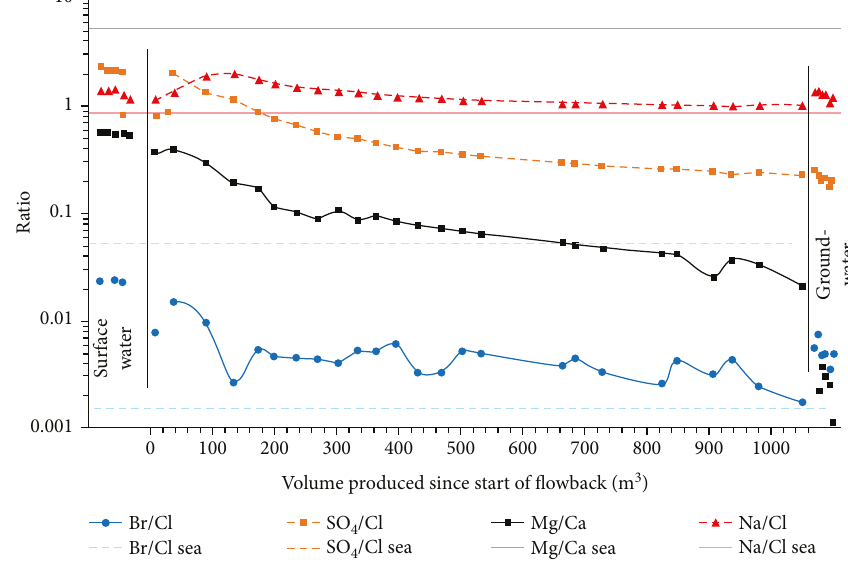
Figure 10: The same hydrochemical data as in Figure 9, for water produced from well PX-1 during August-September 2017, compared with fi ve analyses of the surface water used as the source and six analyses indicative of the composition of preexisting groundwater in this well, but plotted as a function of the volume of produced water rather than as a function of time. Patterns, as fl owback proceeds, include the tenfold 2- /Cl - ratio, in a manner explicable by mixing of a progressively greater proportion of groundwater with a progressively decrease in the SO 4 smaller proportion of surface water. Conversely, the Na + /Cl - ratio is similar in the surface water and groundwater, thus insensitive to mixing, but “ spikes ” by a factor of ~ 2 during the initial ~ 500 m 3 or ~ 30 hours of fl owback, this variation being explicable as a result of reaction between the injected water and the granite. Note that the fi rst 74 m 3 of produced water remained within the casing of well PX-1 after injection and so did not interact with the Pohang